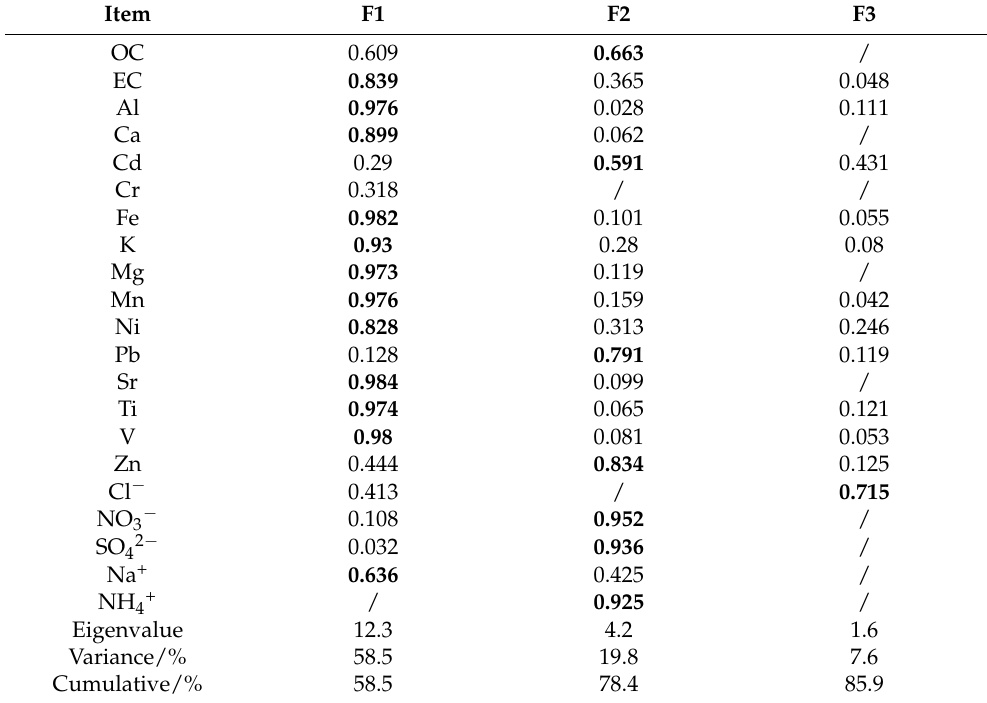
Table 1. Rotated principal component analysis for components in